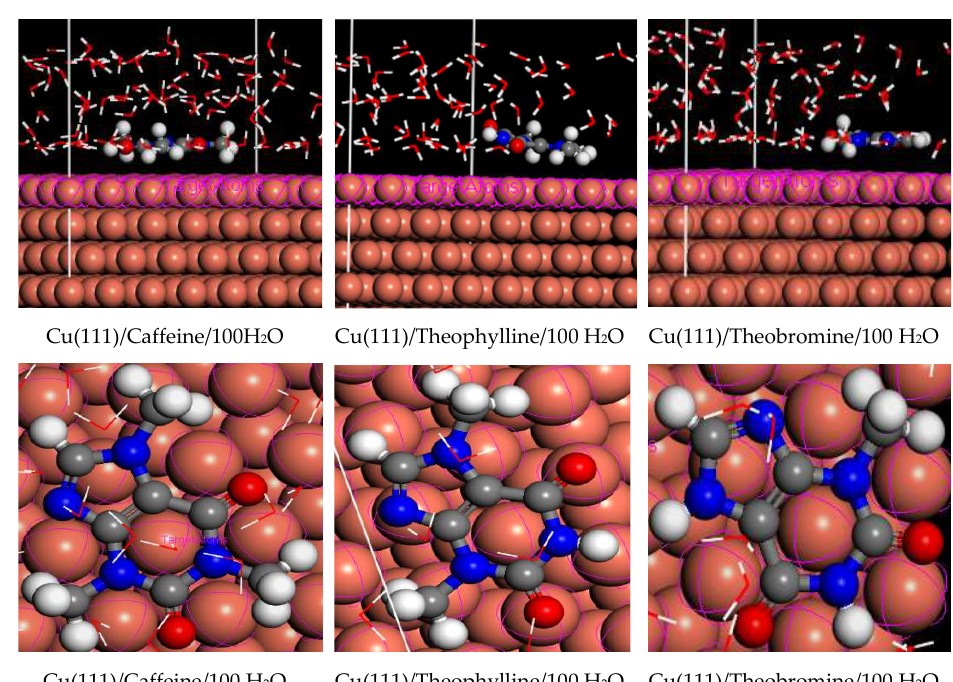
Figure 3. Top and side views of the most stable low energy configuration for the adsorption for Cu(111)/Caffeine/100H 2 O, Cu(111)/Theophylline/100H 2 O, and Cu(111)/Theobromine/100H 2 O systems. Table 7. Adsorption Energy for the most stable configurations for Cu(111) / Caffeine / 100H 2 O, Cu(111) /